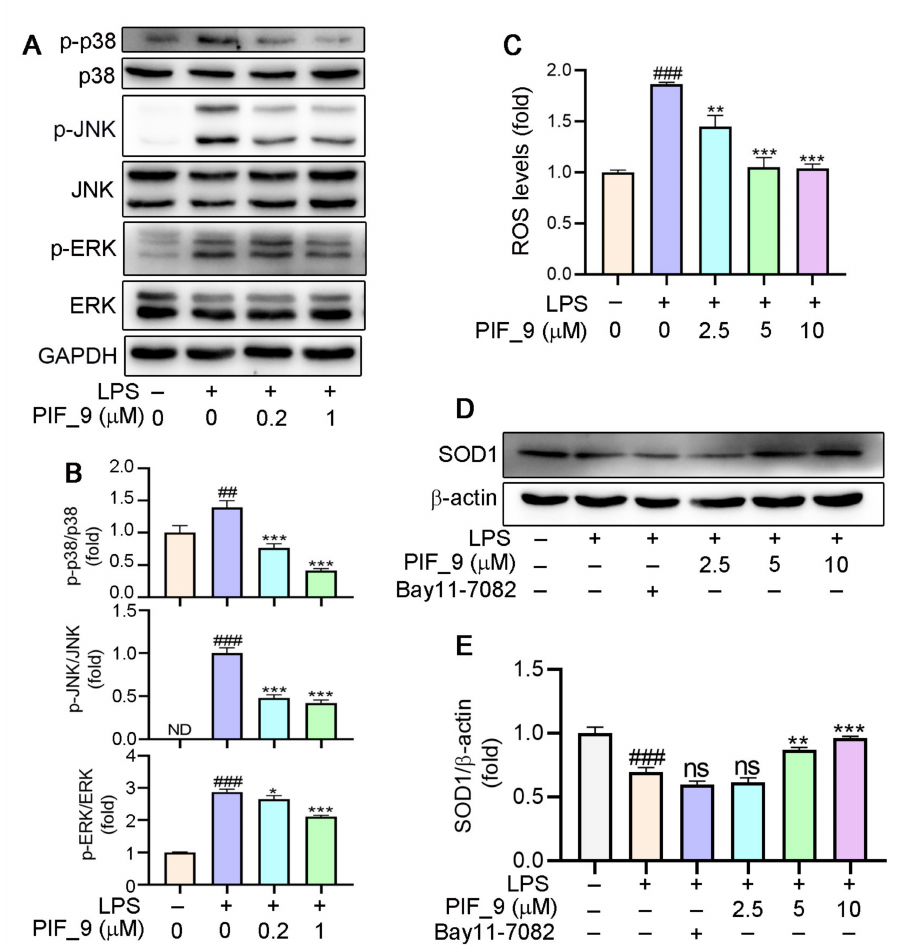
Figure 5. ( A , B ) Compound PIF_9 inhibited the activation of MAPK signaling pathway. RAW264.7 cells in a 6-well plate cultured in serum-free medium were pretreated with compound PIF_9 for 1 h, then co-treated with LPS (100 ng/mL) for 2 h. ( C ) RAW264.7 cells were pretreated with compound PIF_9 for 1 h, then co-treated with LPS (100 ng/mL) for 24 h. Cellular ROS levels was determined by detection of DCF fluorescence intensity as described in Materials and Methods. ( D , E ) RAW264.7 cells were pretreated with compound PIF_9 for 1 h, then co-treated with LPS (100 ng/mL) for 24 h. After treatment, cellular protein was extracted and protein expression levels of p-JNK, JNK, p-p38, p38, p-ERK, ERK (A,B), and SOD1 (D, E) were analyzed by Western blot, followed by quantitative analysis of band density as described in Materials and Methods. ## , p < 0.01, ### , p < 0.001, vs. Control; *, p < 0.05, **, p < 0.01, ***, p < 0.001 vs. LPS-treated group; ns, no significant difference; ND, no detection ( n =